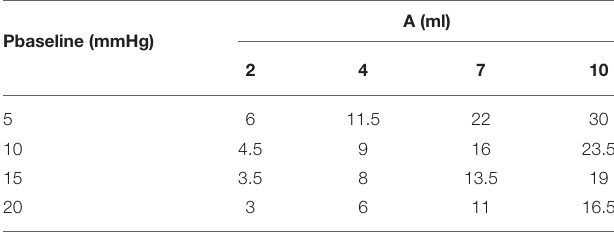
TABLE 2 | Volumes (ml) of fluid bolus injections at which the epidural pressure exceeds 100 mmHg, for different baseline epidural pressures and values of A.